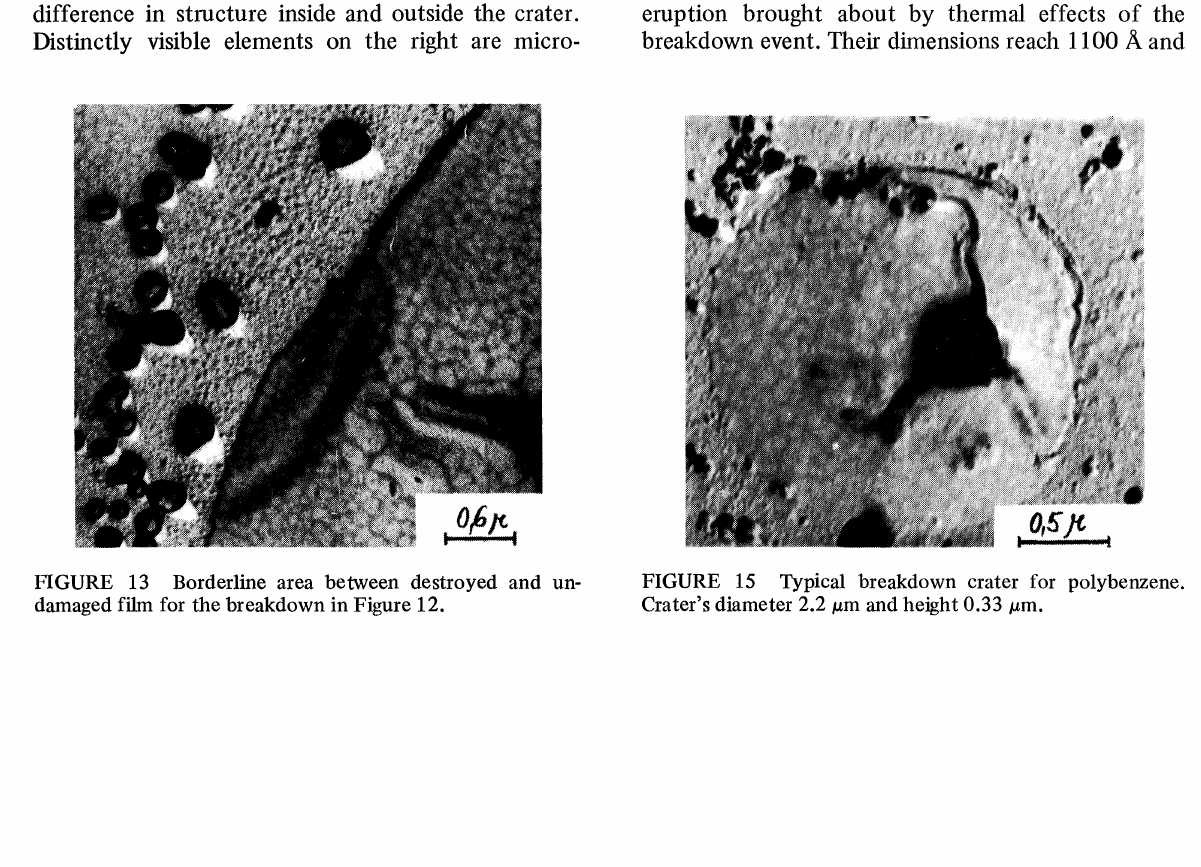
FIGURE 14 Typical breakdown crater for polybenzene (d 2500 A). Crater’s diameter 1.9 m and height 0.64 um.